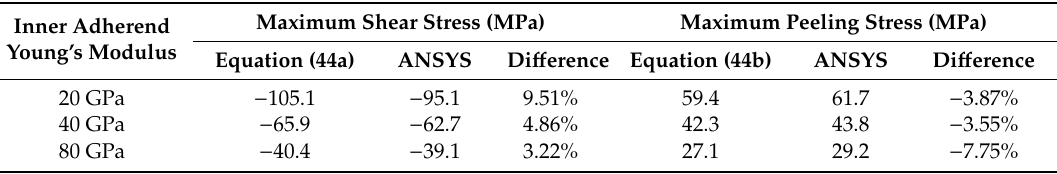
Table 6. Comparison of maximum interfacial stresses with di ff erent inner adherend Young’s modulus obtained by Equation (44) and